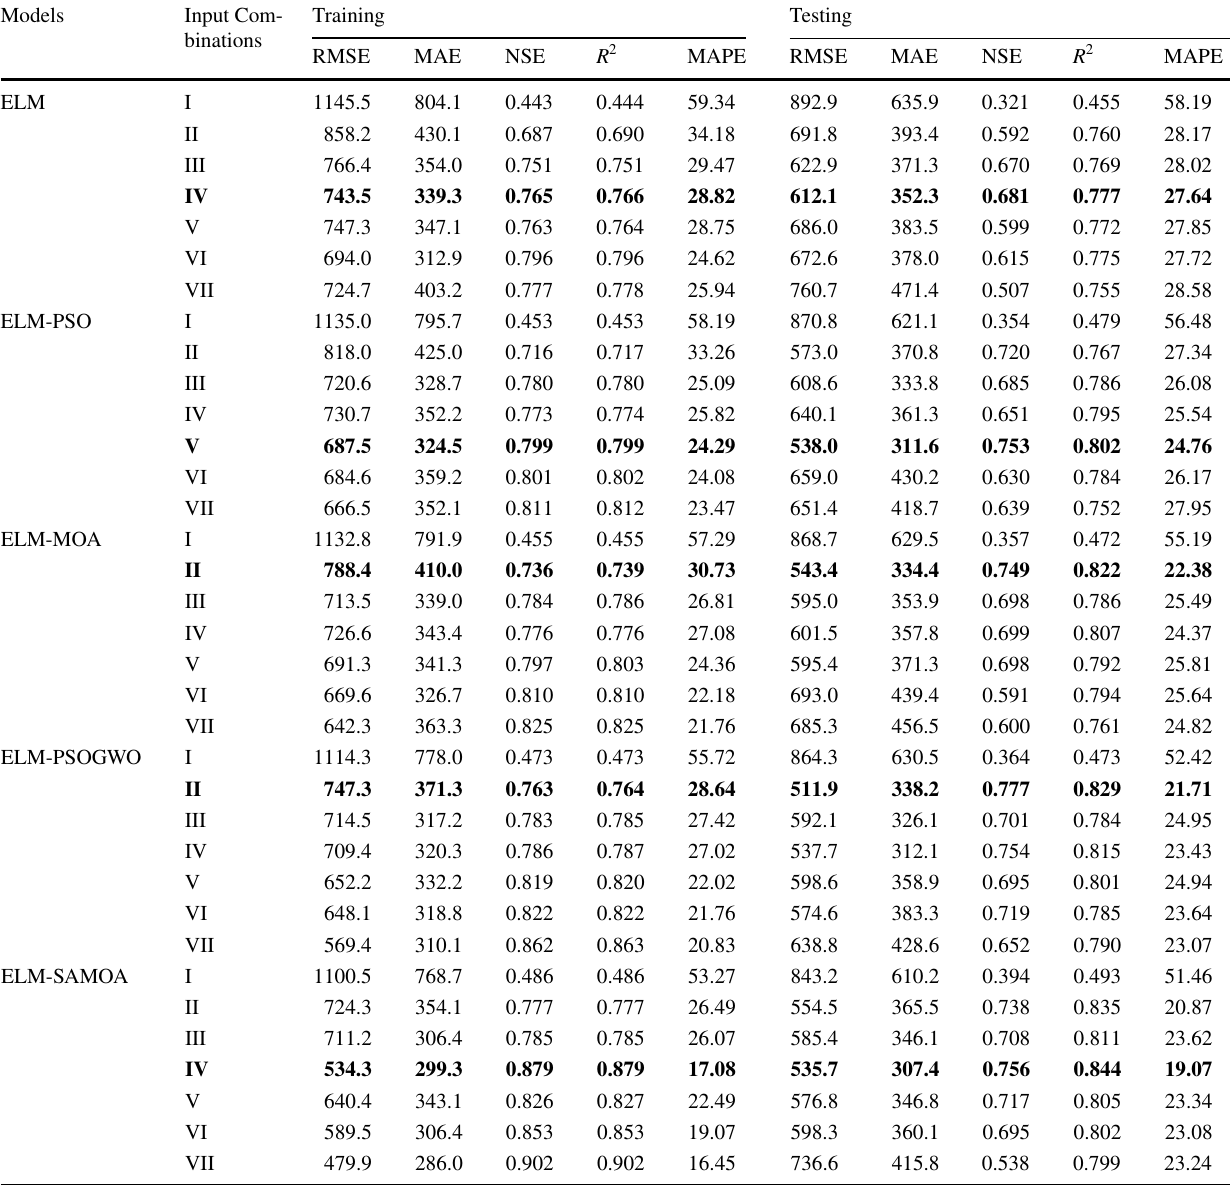
Bold values defines the best accuracy (meaning the slowest RMSE and MAE and highest NSE